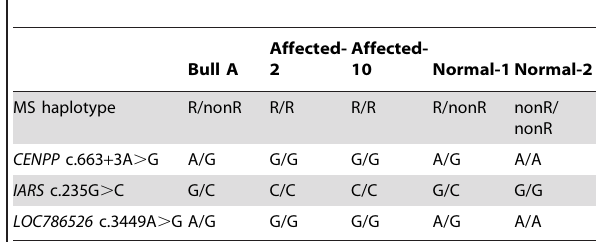
Table 2. Genotyping with the Bull A family used for mapping.